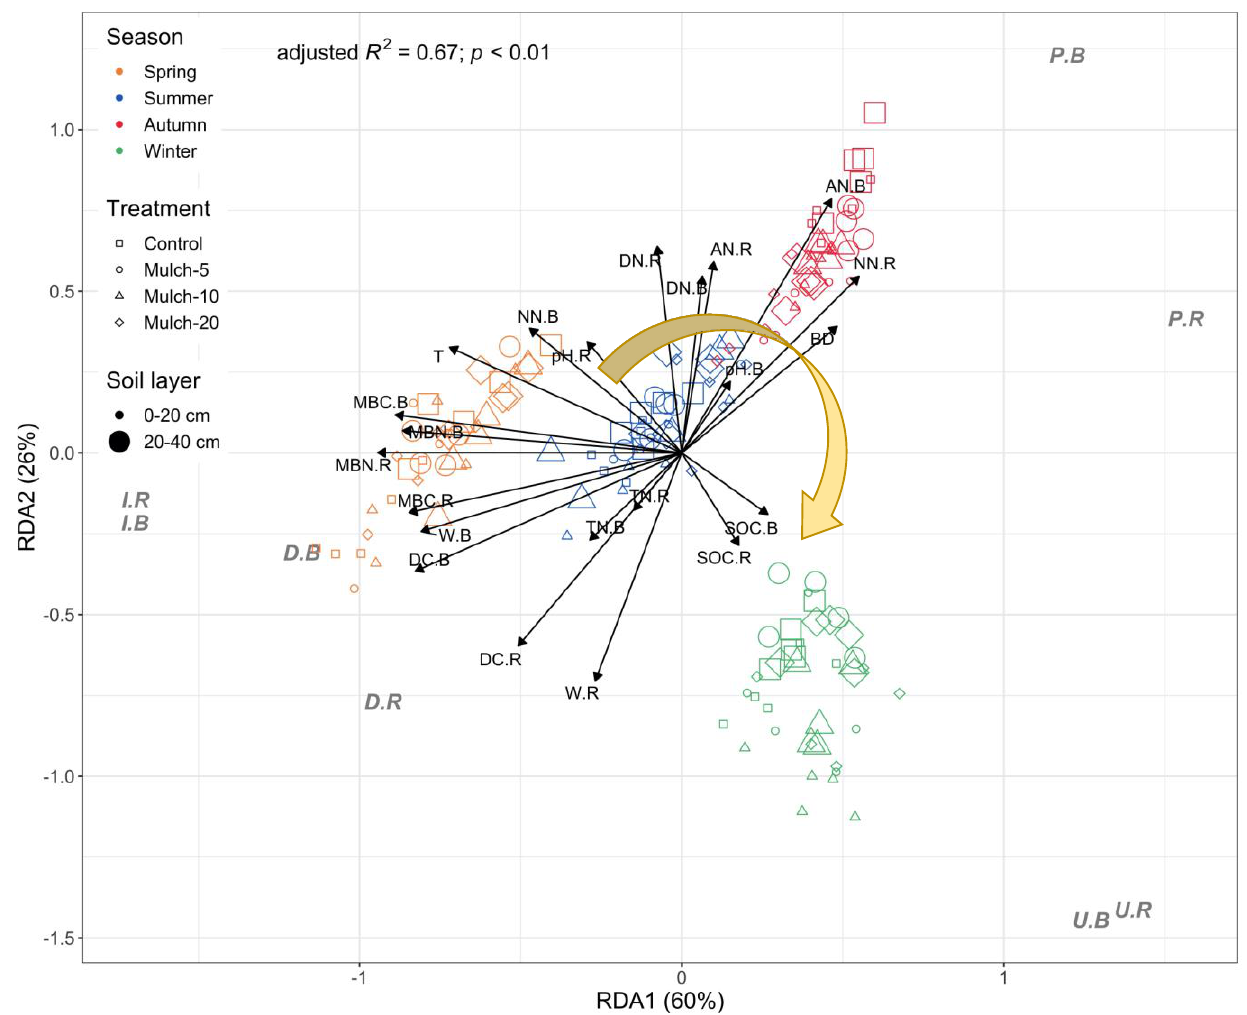
Figure 5. Redundancy analysis (RDA) ordination plot of enzyme activities constrained by environmental variables that significantly explain the variation. I: invertase; U: urease; P: peroxidase; D: dehydrogenase; T: temperature; W: water content; BD: bulk density; SOC: soil organic C; TN: total N; DC: dissolved C; DN: dissolved N; AN: ammonium; NN: nitrate; MBC: microbial C; MBN: microbial N. “B” means “in bulk soil” and “R” means “in rhizosphere”. The RDA was performed based on original data (Figures S1 and S2). The curved arrow indicates the development of enzyme activities over the year.